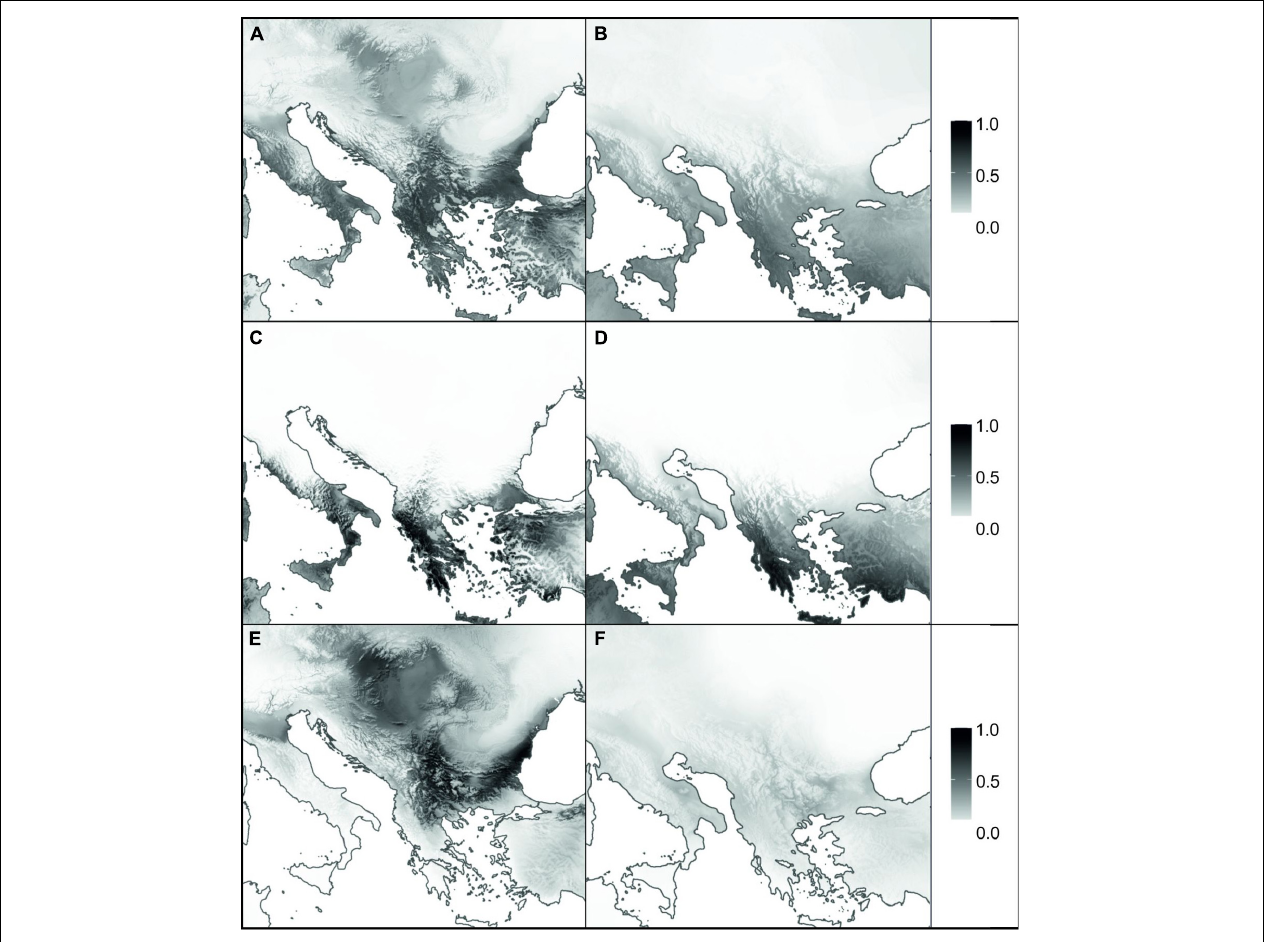
FIGURE 4 | Species distribution models for Aurinia saxatilis under current (A,C,E) and Last Glacial Maximum (B,D,F) climatic conditions. Panels (A,B) represent the models for complete distribution of A. saxatilis , whereas (C–F) are models for two distinct evolutionary lineages of A. saxatilis , namely the South Balkan-Apennine Group and the rest of the distribution, respectively (marked with blue and red symbols in Supplementary Figure 1 ). Grey shading corresponds to habitat suitability, ranging from 0 (white: no suitability) to 1 (black: maximum